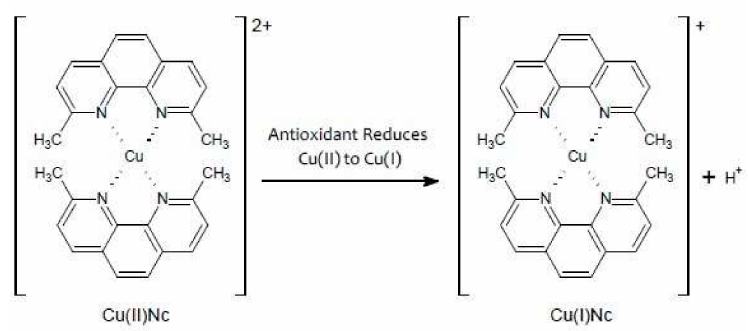
Figure 6. Chemical change in CUPRAC assay.